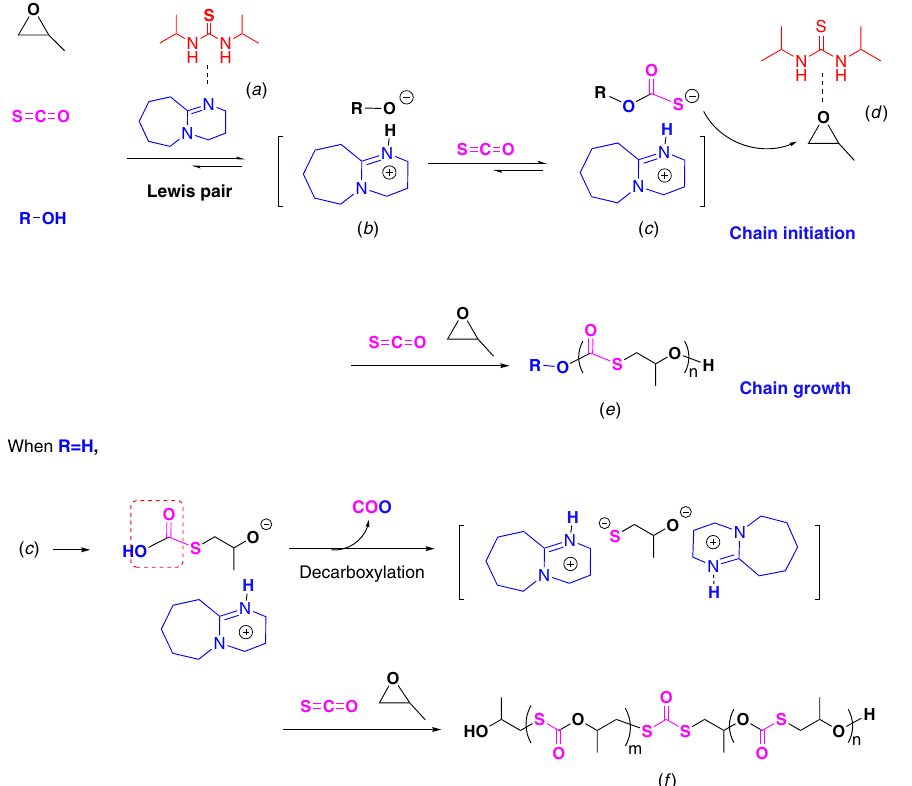
Fig. 6 Proposed anionic copolymerization mechanism. Chain initiation and growth routes are presented upon the cooperative catalysis of TU-1/DBU pair in the presence of BnOH and H 2 O. Species ( a ) – ( d ) were revealed by Fig. 5 and Supplementary Figs. 24 – 26; copolymer distributions ( e ) and ( f ) were evidenced by Fig.